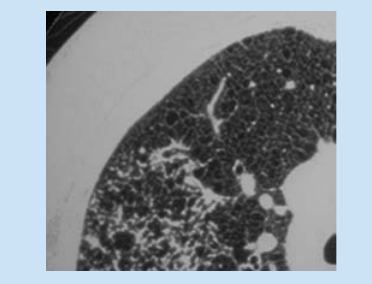
Fig. 26. Fibrosing